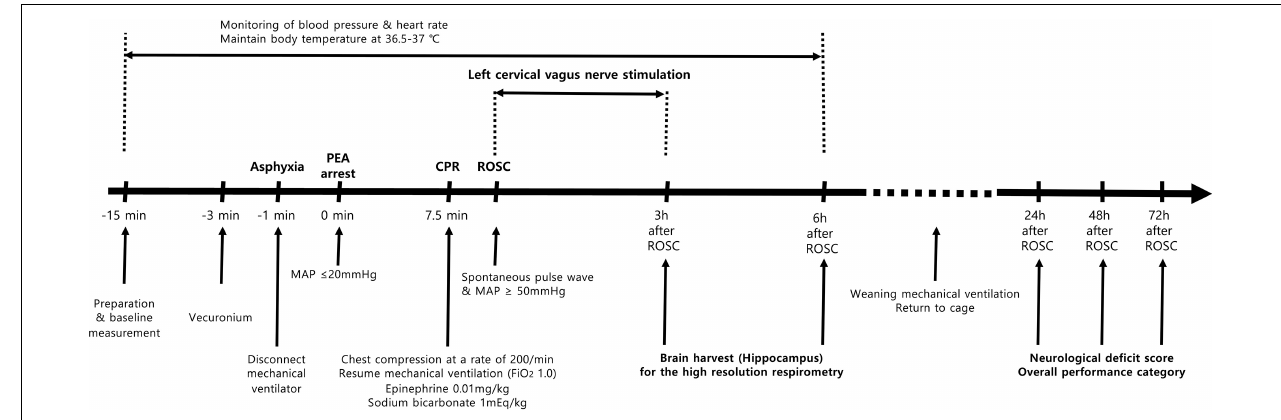
FIGURE 1 | Schematics of the experimental